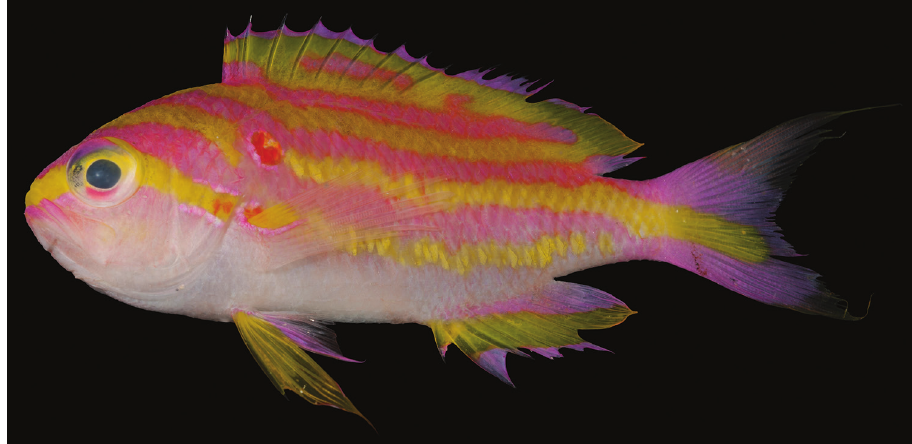
Figure 7. Tosanoides flavofasciatus , BPBM 40858, Palau Islands. Photo by R. L.